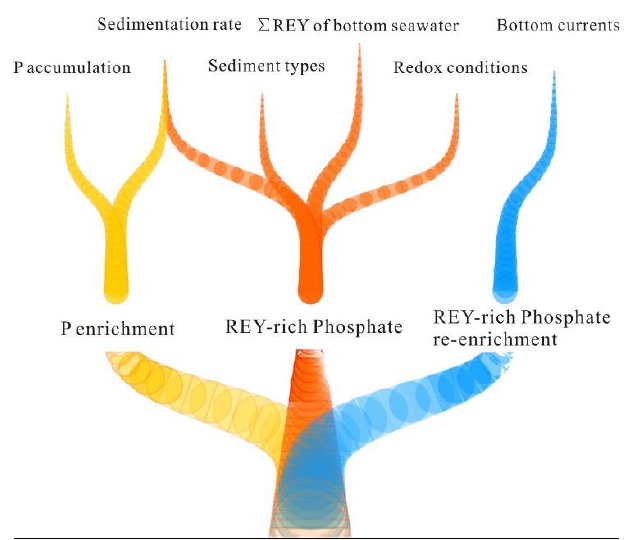
Figure 10. Schematic diagram of the factors influencing REY enrichment in deep-sea sediments and their correlations. REY enrichment can be understood as three important processes: P enrichment, the formation of REY-rich phosphate, and the physical re-enrichment of REY-rich phosphate. The accumulation, of P sedimentation rate, ΣREY of bottom seawater, sediment type, redox conditions, and bottom currents have different effects on REY enrichment. The relationships among them are connected by the branches.